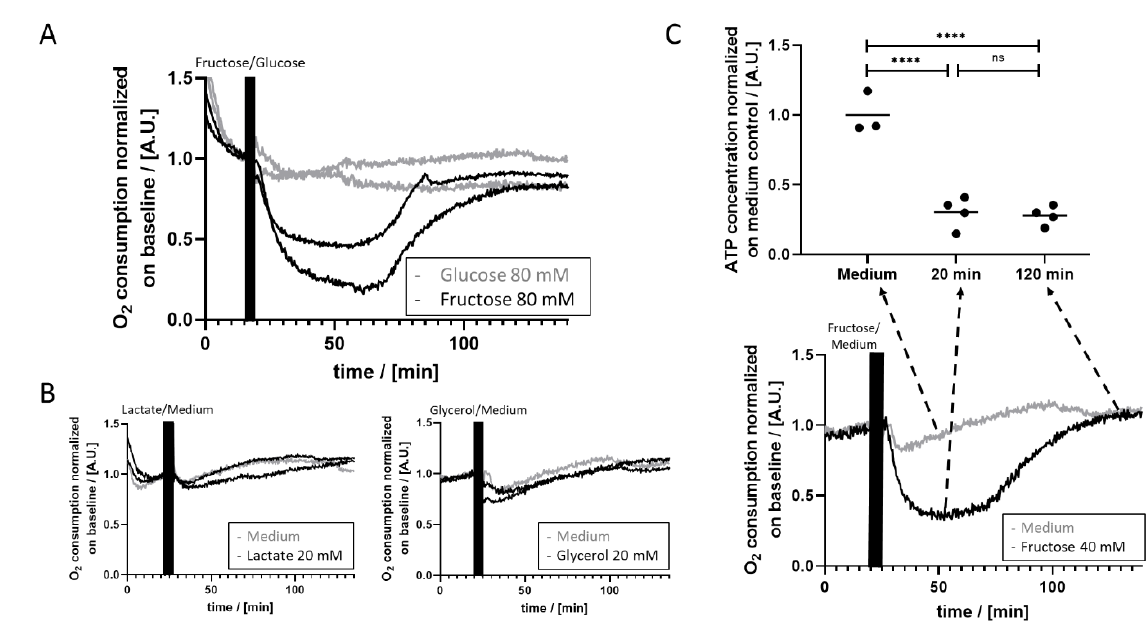
Figure 3: OC and ATP-levels after fructose treatment of PHH. A ) While OC rapidly decreases to < 50 % of the basal OC in response to fructose treatment and reaches initial levels again after approximately 110 minutes (black graphs), glucose treatment did not substantially affect OC (grey graphs). B ) Cells were treated with 20 mM lactate (left) and 20 mM glycerol (right). Neither lactate nor glycerol affected OC in comparison to control cells treated with medium only. C ) The ATP level determined 20 min after the start of the fructose treatment decreased to approximately 30 % of the level of non-treated control cells. Even after reaching close-to-initial levels of cellular OC (illustrated in panel below), the ATP levels did not increase but remained at 30 % of the control cells two hours after the start of the fructose treatment (n = 3 for medium, n = 4 for 20 min and 120 min fructose; significance: **** equals p-values < 0.0001).